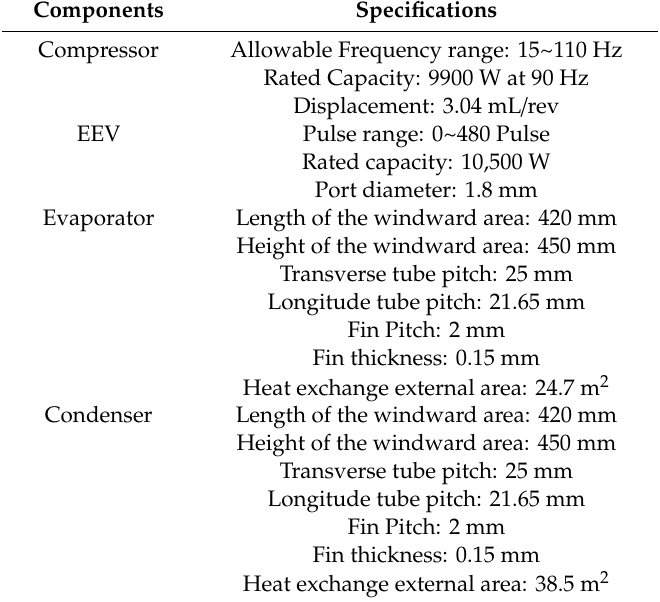
Figure 1. Schematic diagram of the modeled DX A/C system. Table 1. The specifications of each components of the modeled DX A/C system.